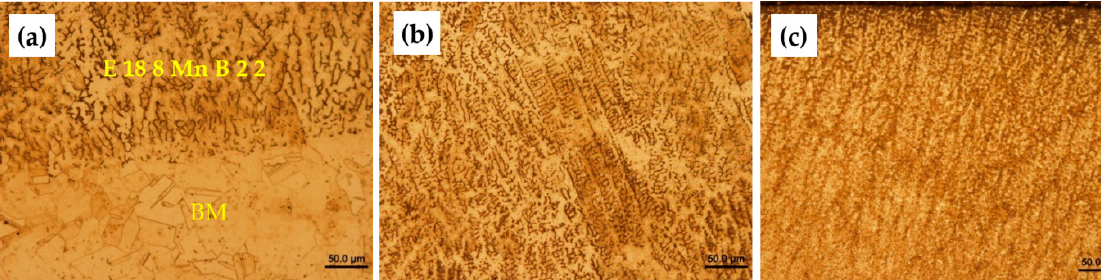
Figure 8. E Ni 6625 weld—EDX semi-quantitative microanalyses (mapping).